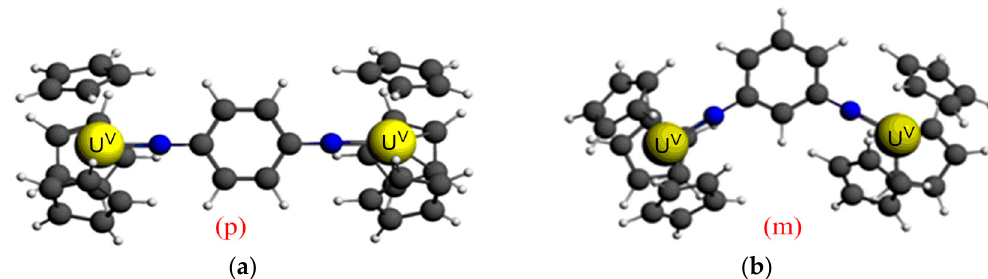
Figure 12. Structures of the para ( a ) and meta ( b ) imido diuranium(V) complexes (reprinted with permission from [146], Elsevier, 2012).